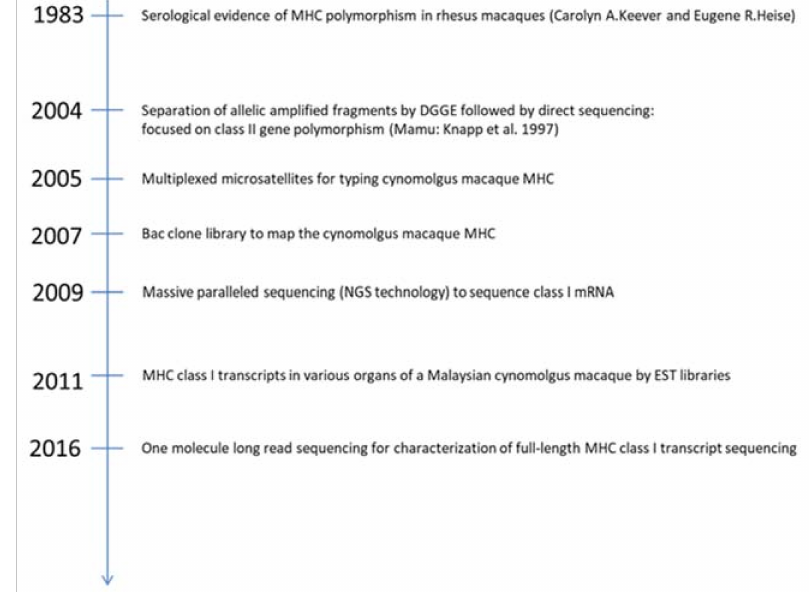
Figure 1. Milestones of cynomolgus macaque MHC